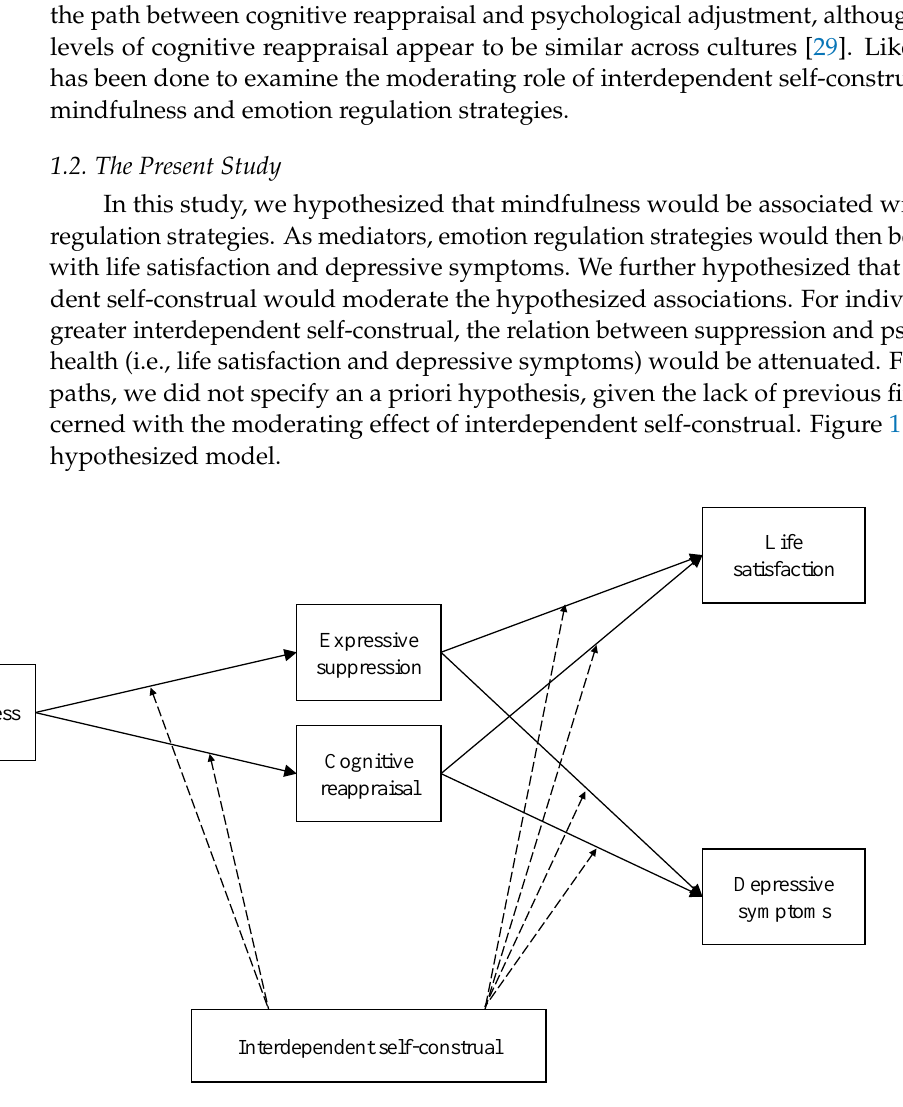
Figure 1. Conceptual model of mindfulness, emotion regulation, and psychological health, with interdependent self-construal as a moderator. In the analyses, the direct effects of mindfulness on life satisfaction and depressive symptoms were included to assess the mediation effects of emotion regulation strategies.